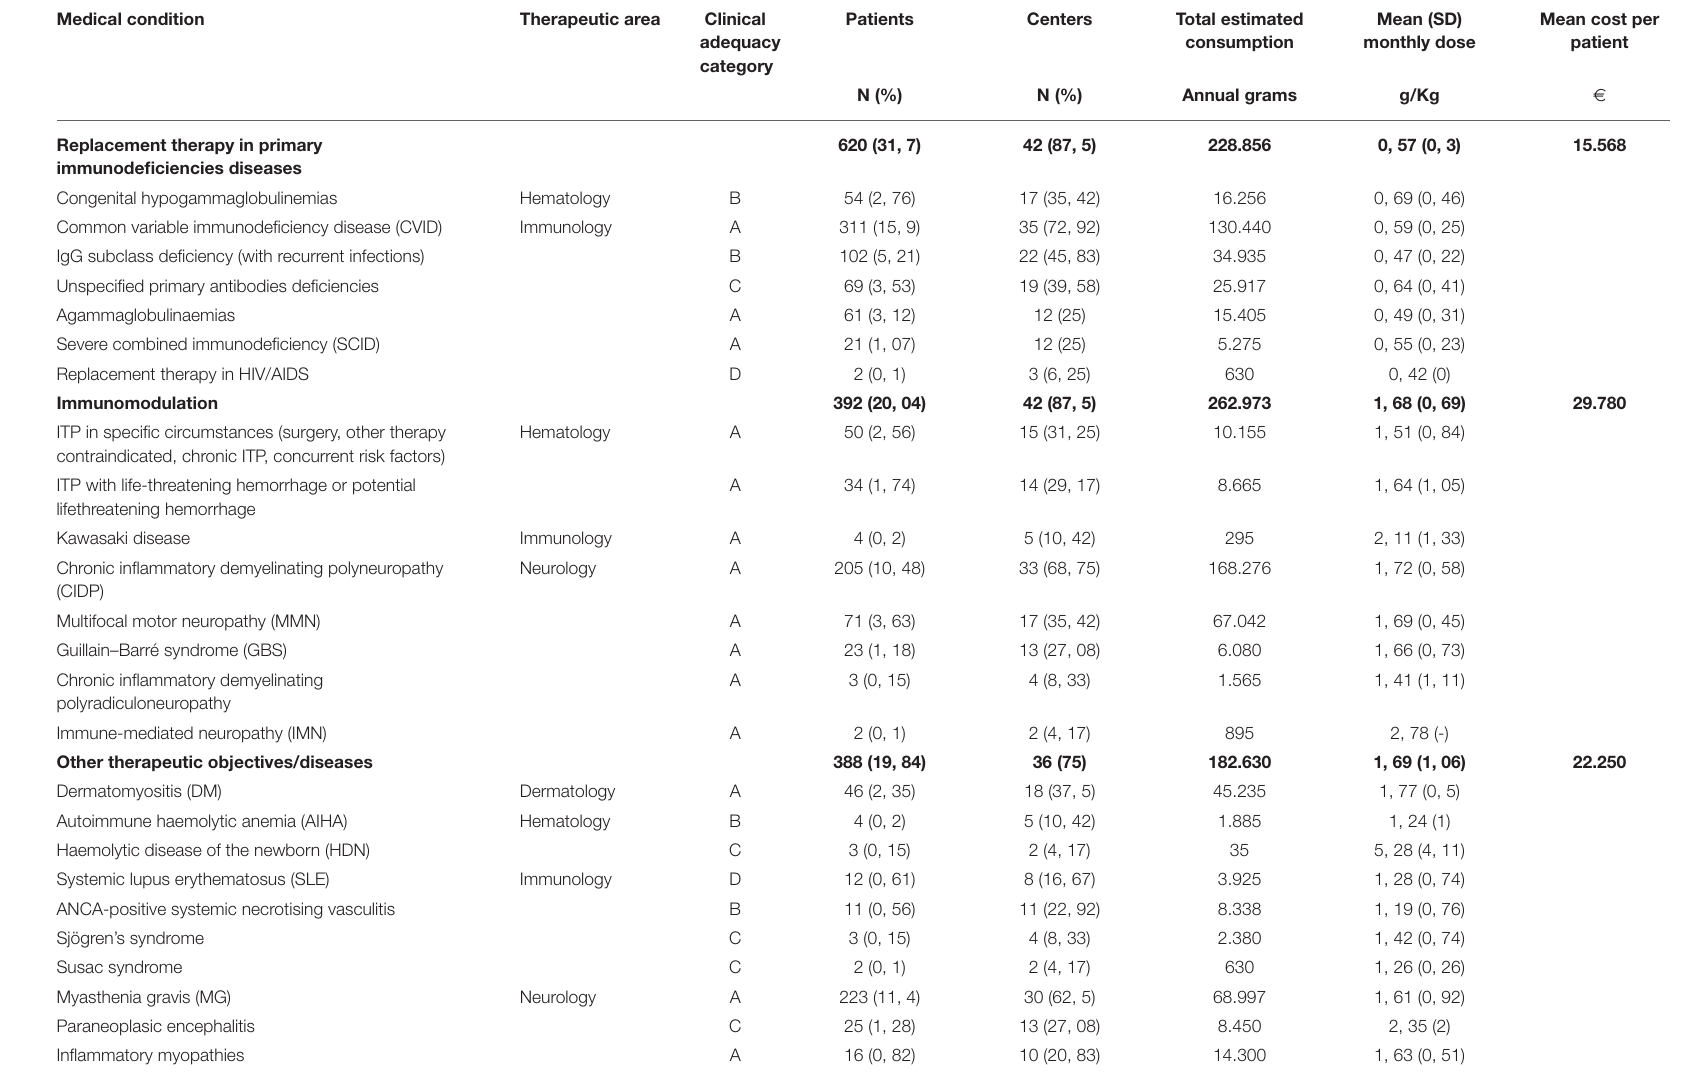
TABLE 1 | Description of IgG use in year